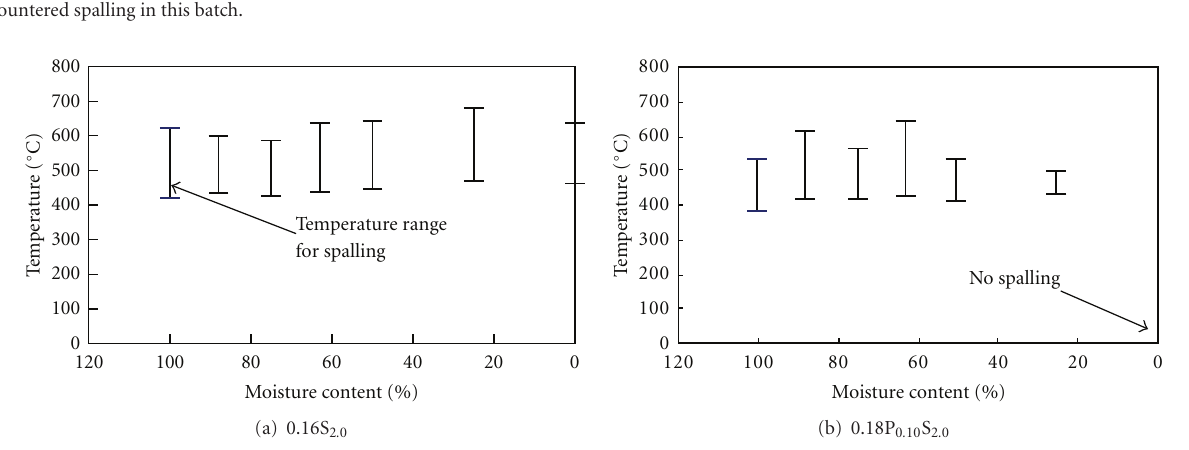
Figure 2: Temperature range for spalling of two types of RPC with various moisture